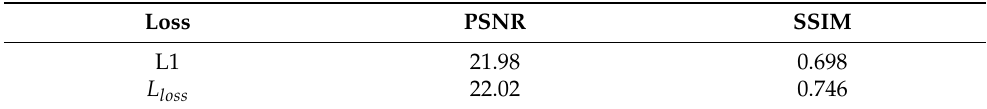
Table 2. Ablation study of the loss